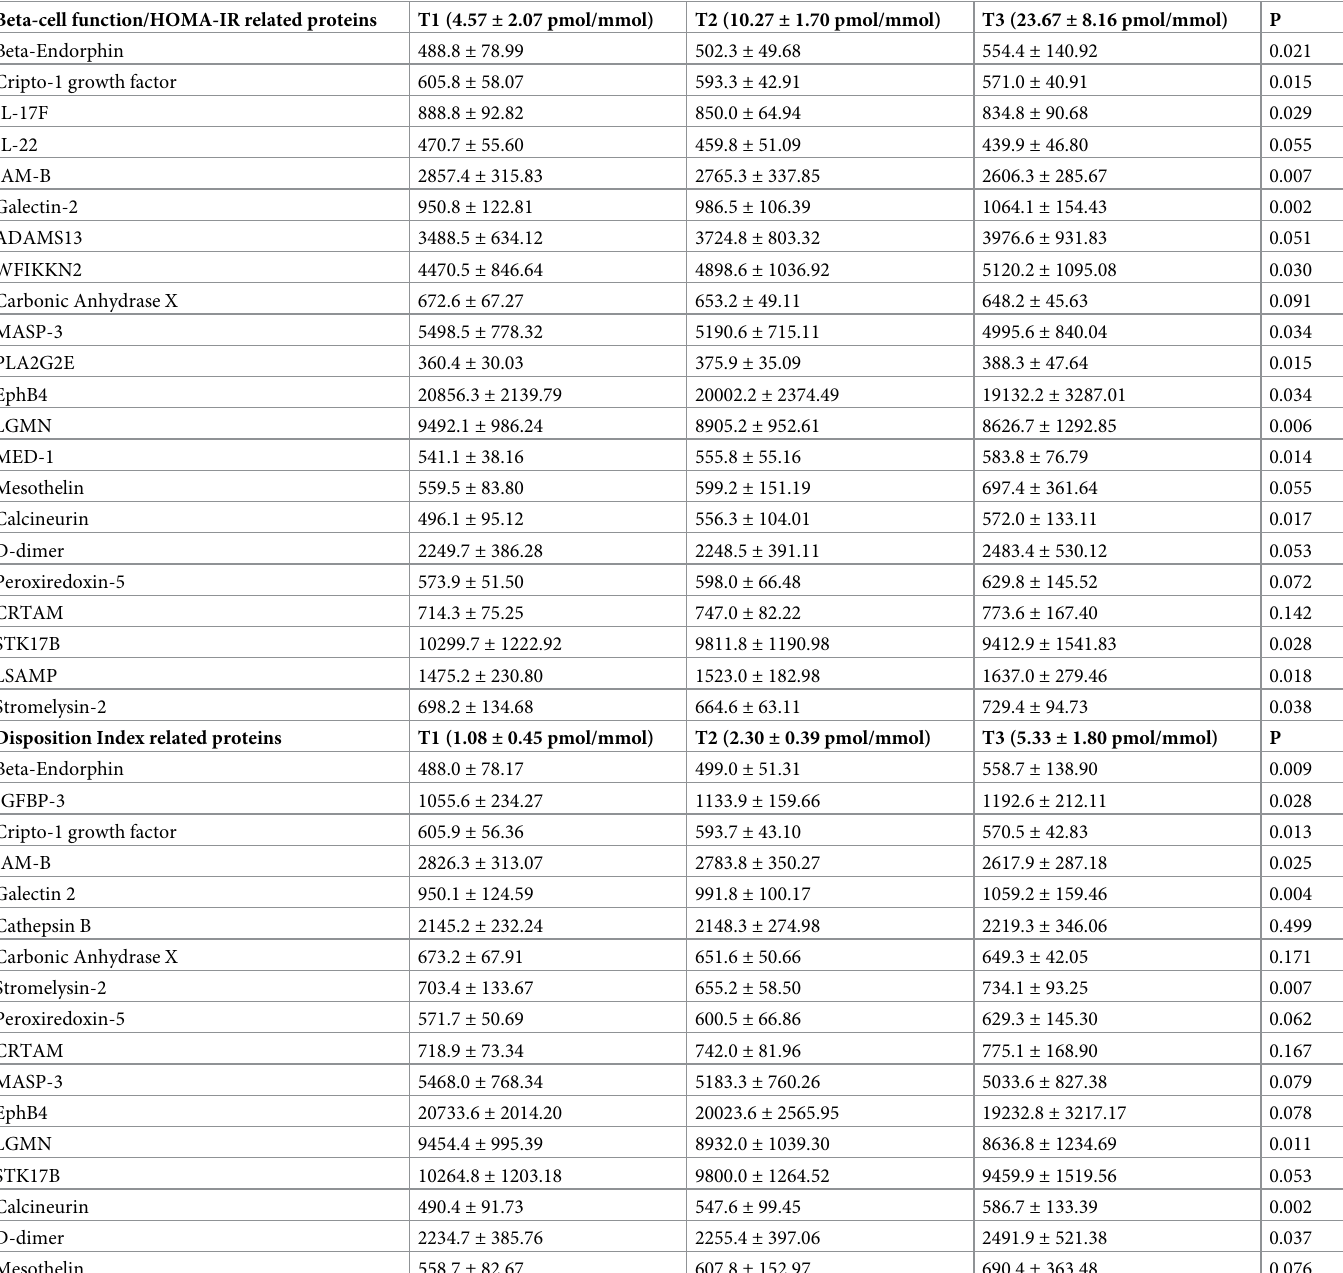
Table 3. Protein concentrations across tertiles of beta-cell function measures.